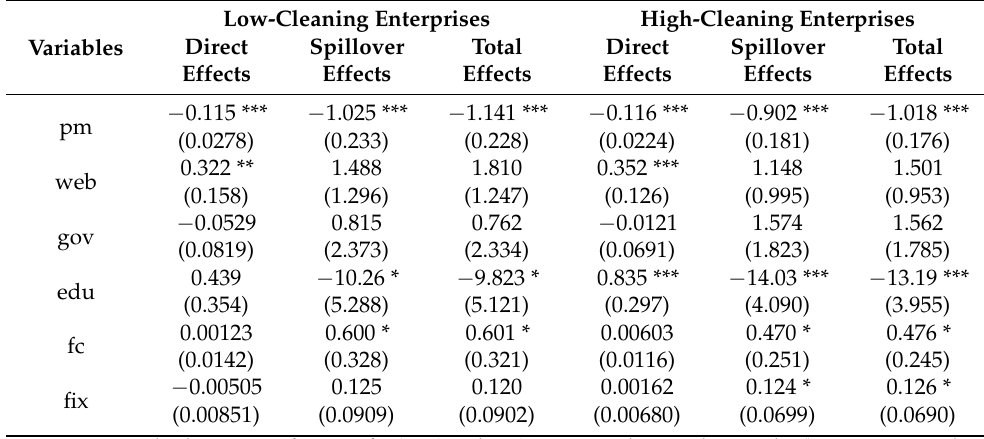
Table 9. Results based on heterogeneity of enterprises’ pollution